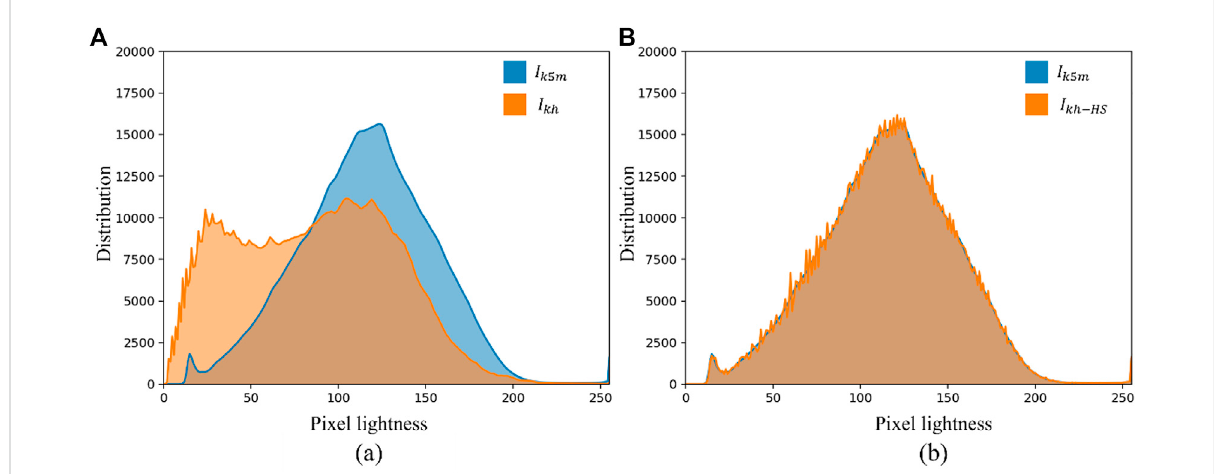
The bold value here means the smallest RMSE and the best performance.